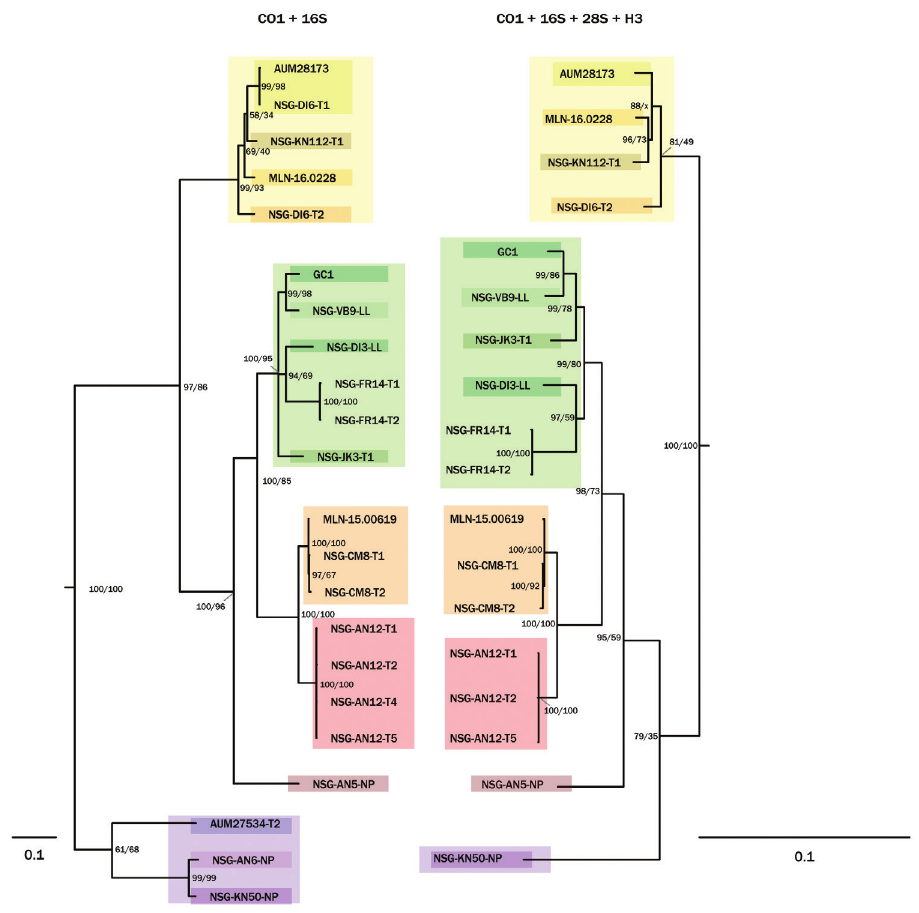
Figure 5. Phylogenetic trees of the concatenated mtDNA (CO1 + 16S; 1316 bp) and the full mtDNA + nDNA (CO1 + 16S + 28S + H3; 3040 bp) datasets. Posterior probabilities generated from the analyses are shown for each clade with the top numbers. Confidence values given from the bootstrapped ML method are shown for each clade with the bottom numbers. The ‘x’ symbols indicate varying topology between the BI and ML analyses. ML trees are reported in the Appendix for cross-reference. Species delimitation results are depicted using major color groups for the mPTP results, and subcolor groups for the ABGD